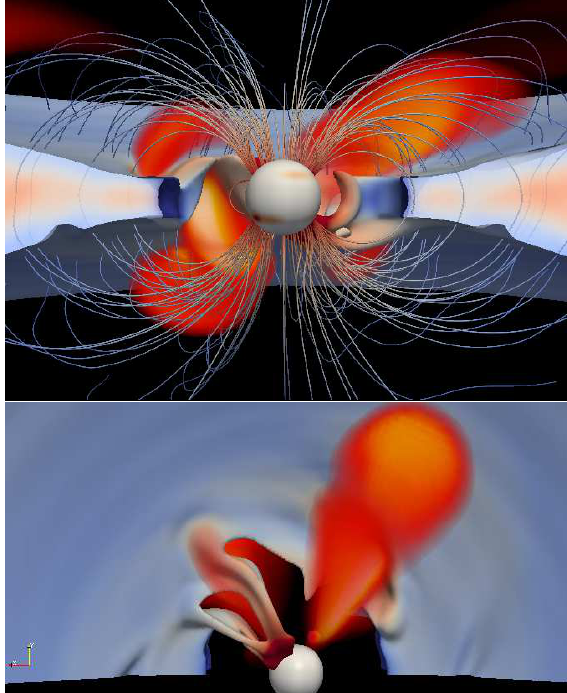
Figure 2: Effects of a storm of flares on the disk sta- bility. Cutaway views of the star-disk system showing the mass density of the disk (blue) at t = 26 hours. The panels over-plot the three-dimensional volume render- ing of the plasma temperature (in MK), showing the flaring loops (in red) linking the inner part of the disk with the star. The upper panel shows the star-disk sys- tem observed edge-on, whereas the lower panel shows the system observed pole-on. Selected magnetic field lines are overplotted in the upper